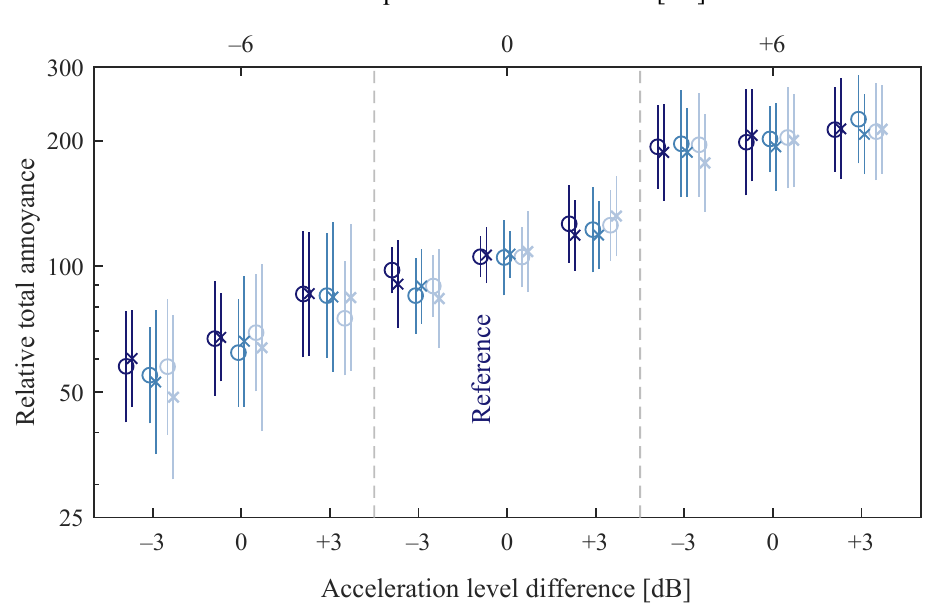
Figure 6. Geometric mean and standard deviation of the evaluations of all participants of the mini excavator (x) and refuse collection vehicle (o) scene sorted by different vibration frequency from 2 Hz (dark blue), 2–10 Hz (blue) and from 10 Hz (light blue); N = 12.